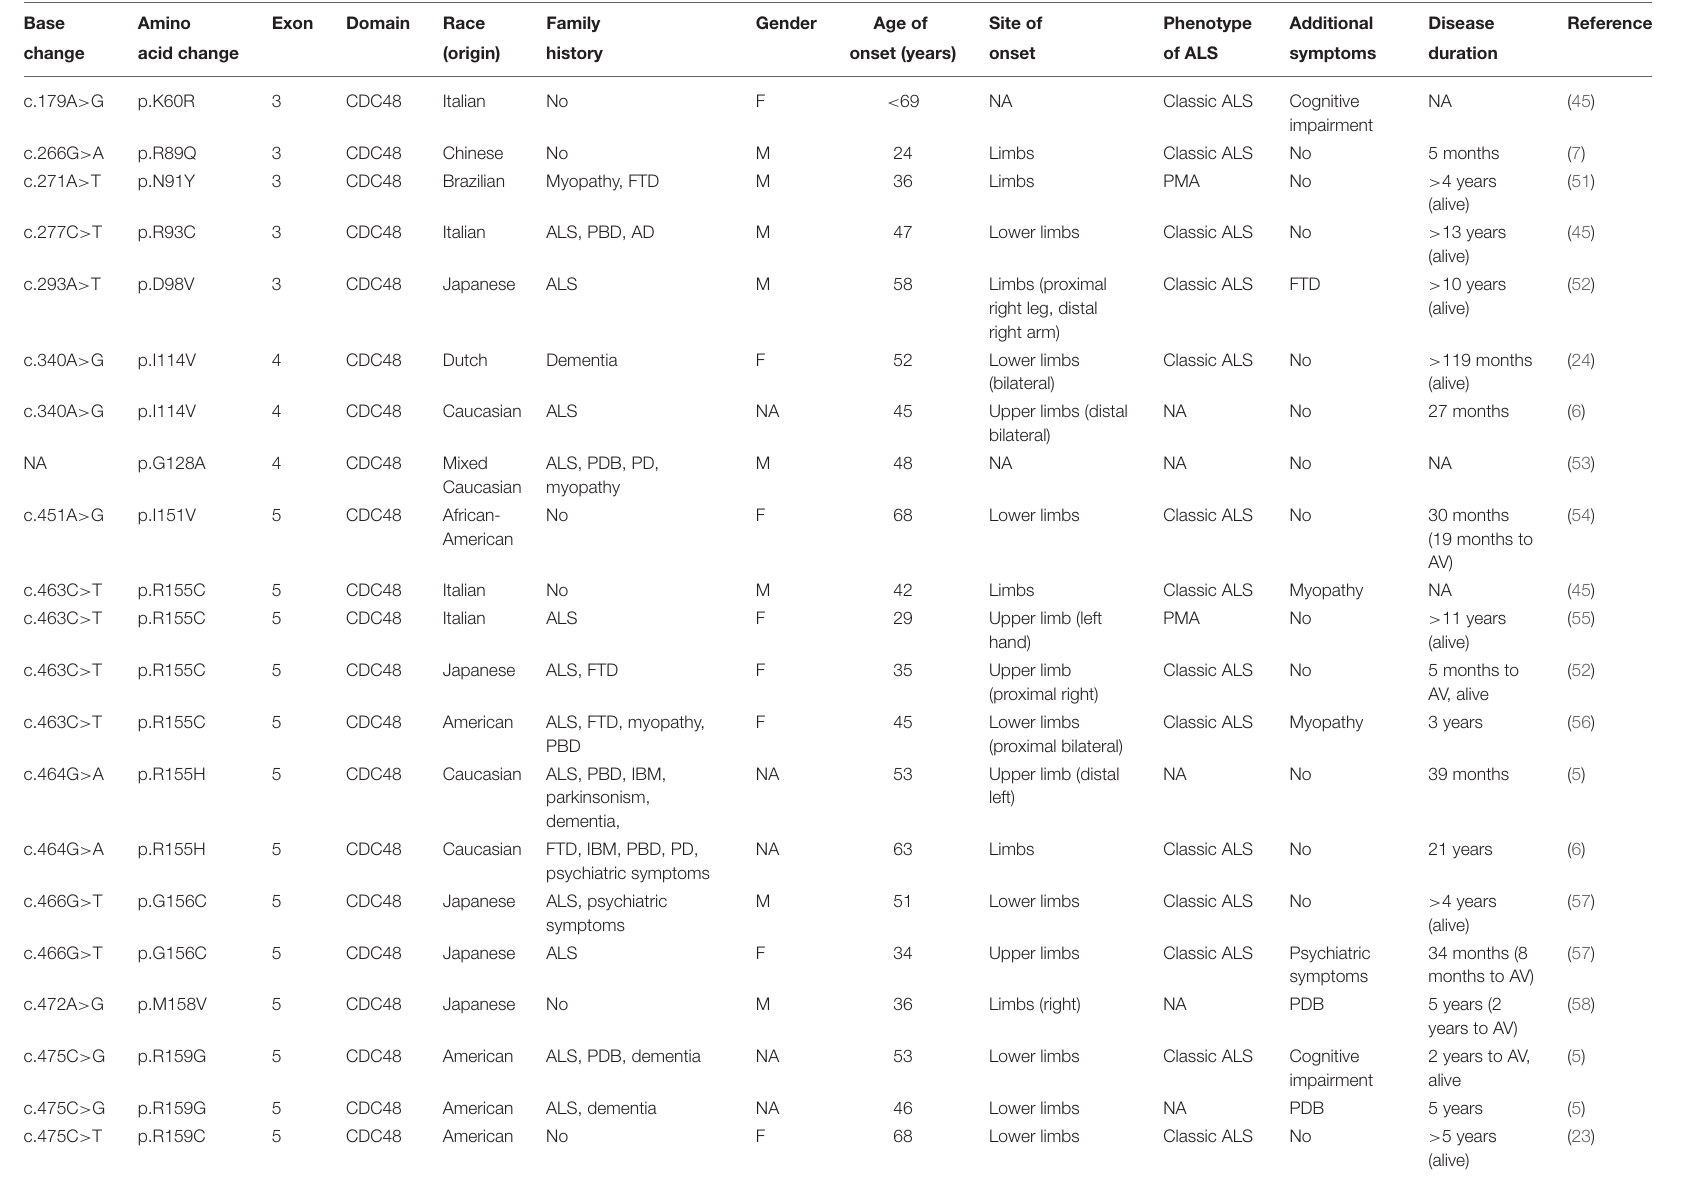
TABLE 3 | Summary of previously published VCP-causing ALS cases with detailed